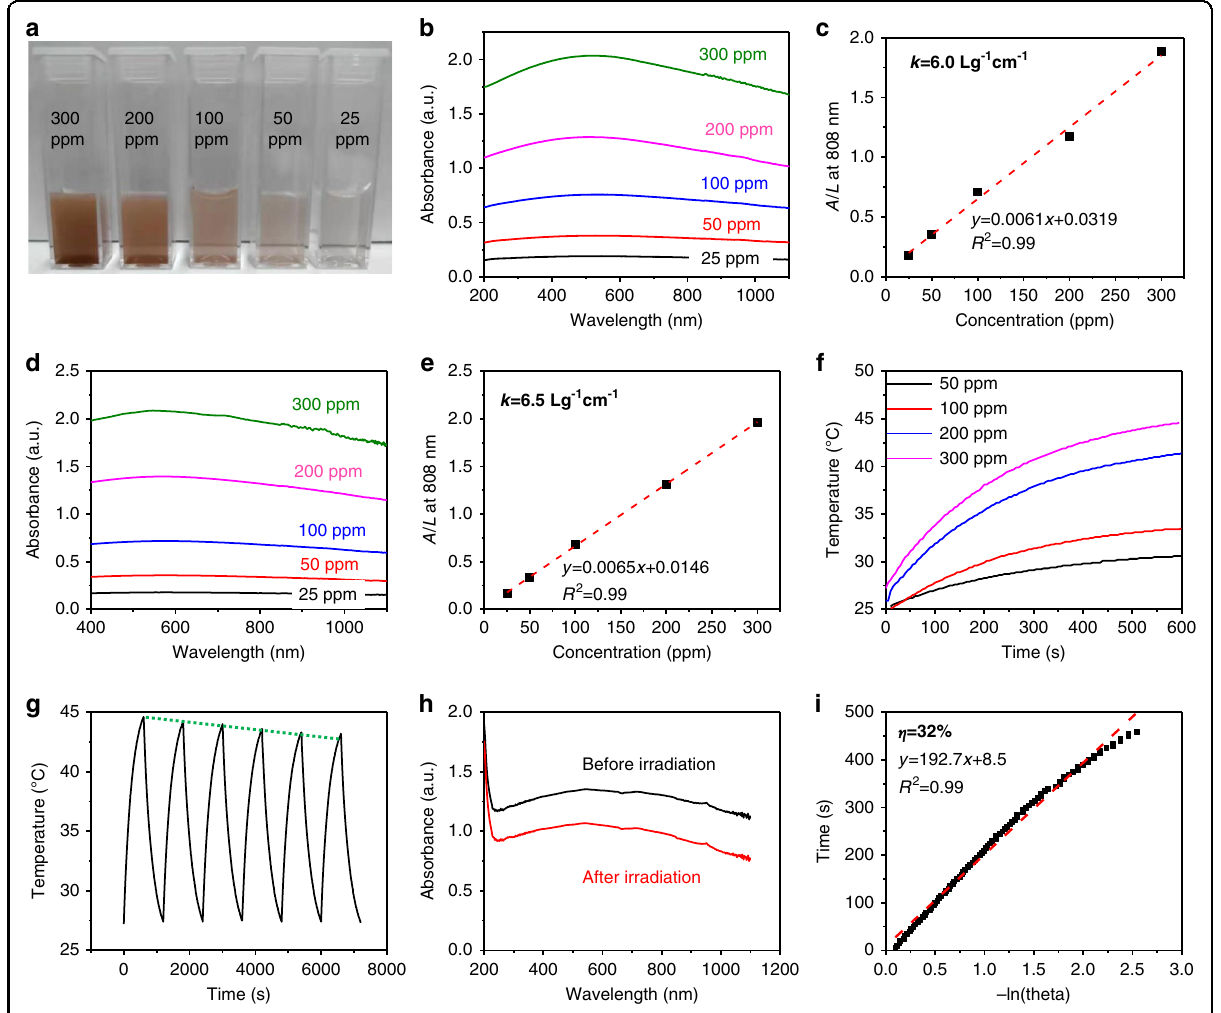
Fig. 4 Photothermal characterizations of borophene. a – c Photograph, absorbance, and extinction coef fi cient of naked borophene. d , e Absorbance and extinction coef fi cient of B@PDA. f Photothermal temperature increases at different concentrations of B@PDA. g Periodic photothermal cycles. h Stability is shown by the absorbance before and after irradiation. i The calculation for photothermal conversion ef fi